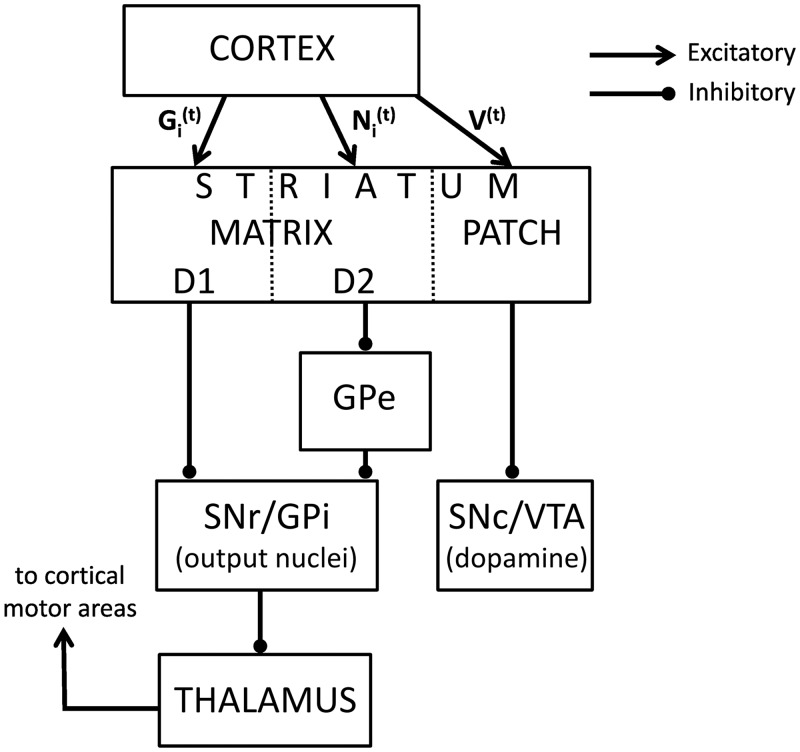
Simplified anatomy of the basal ganglia.The arrows and lines ending with circles denote the excitatory and inhibitory connections respectively. The following abbreviations are used: GPe—external globus pallidus, SNr—substantia nigra pars reticulata, GPi—internal globus pallidus, SNc—substantia nigra pars compacta, VTA—ventral tegmental area.